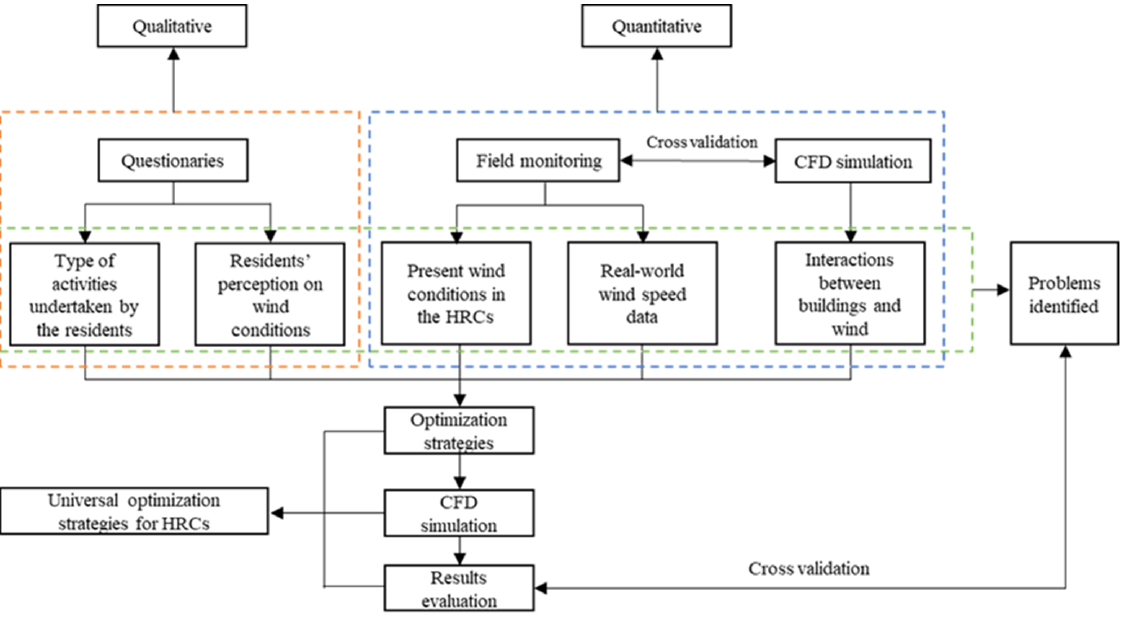
Figure 1. Research methodology.